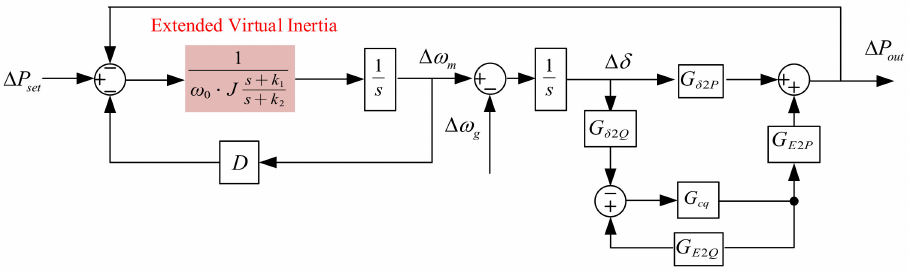
Figure 10. The control block diagram of